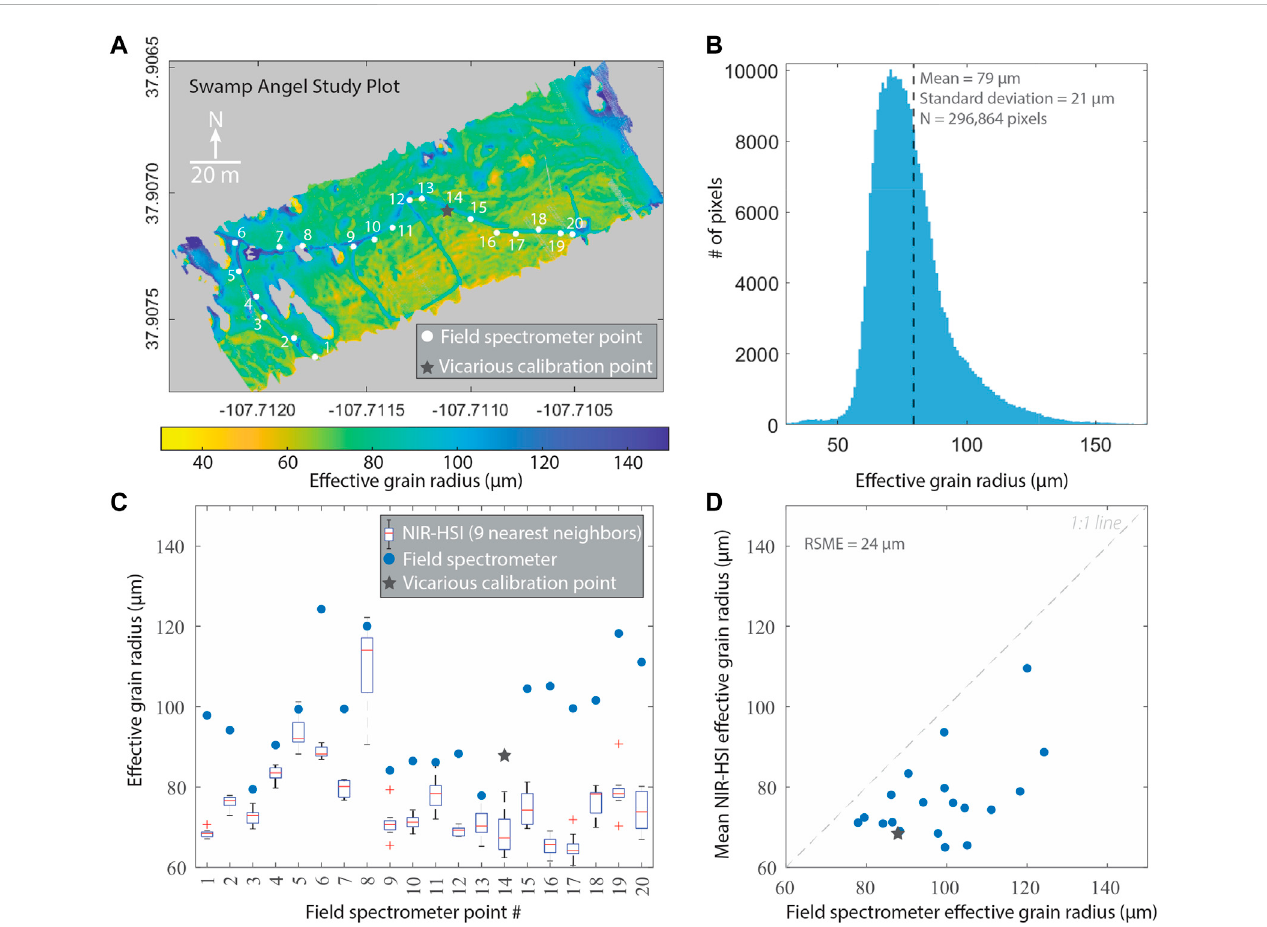
FIGURE 8 Pre-vicarious calibration UAV-HSI grain size retrievals compared to the in situ fi eld spectrometer point measurements. (A) Effective grain size map retrieved from UAV-HSI and the location of the fi eld spectrometer points. (B) Histogram of the UAV-HSI effective grain sizes across the map in (A) . (C) The effective grain size for each fi eld spectrometer point measurement (blue circles) compared against the box plot distribution of UAV-HSI grain sizes in the 9 neighboring pixels (D) One-to-one plot comparing the average (mean) grain size from 9 neighboring UAV-HSI pixels to that from the fi eld